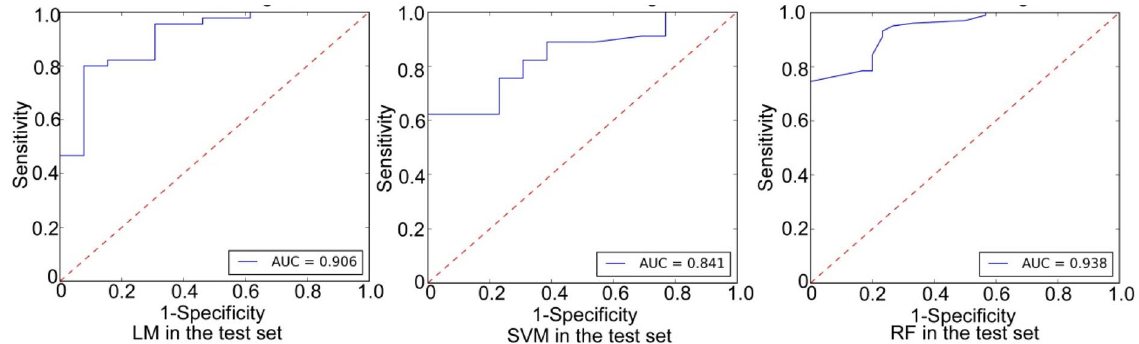
Figure 1. Receiver operating characteristic (ROC) curve analysis of three radiomics models for differentiating clear cell renal cell carcinoma (RCC) from papillary RCC and chromophobe RCC in the testing set. LM logistic regression model, SVM support vector machine model, RF random forest model.